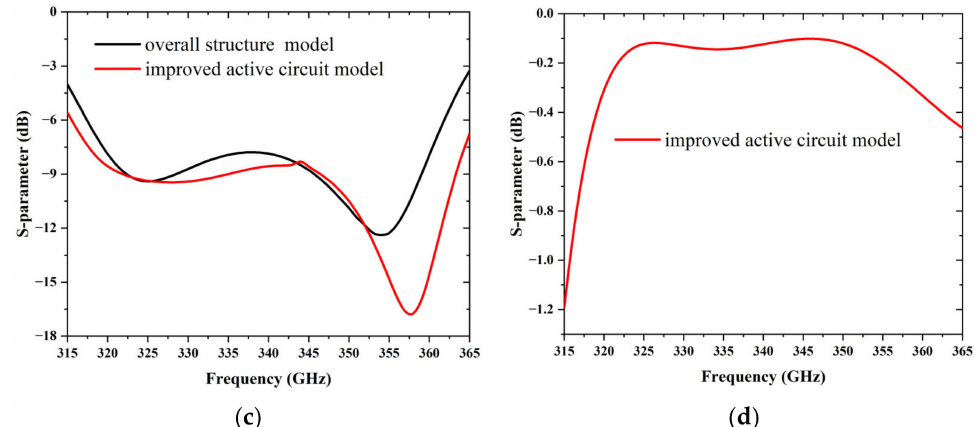
Figure 8. The simulated results of the improved active circuit model and the overall structure model. ( a ) SSB conversion loss; ( b ) RF return loss; ( c ) LO return loss; ( d ) RF insert loss.